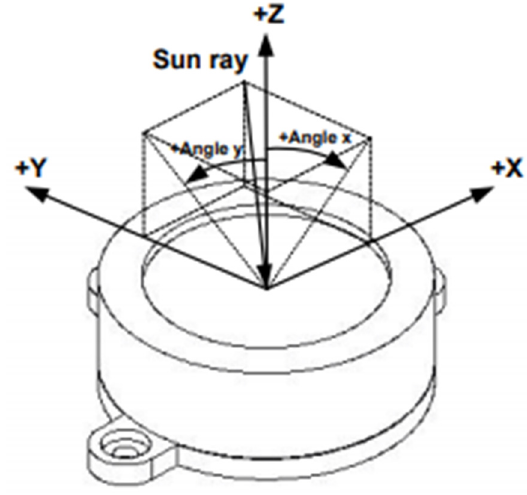
Figure 2. ISS-DX sensor. Reference for measured angles.